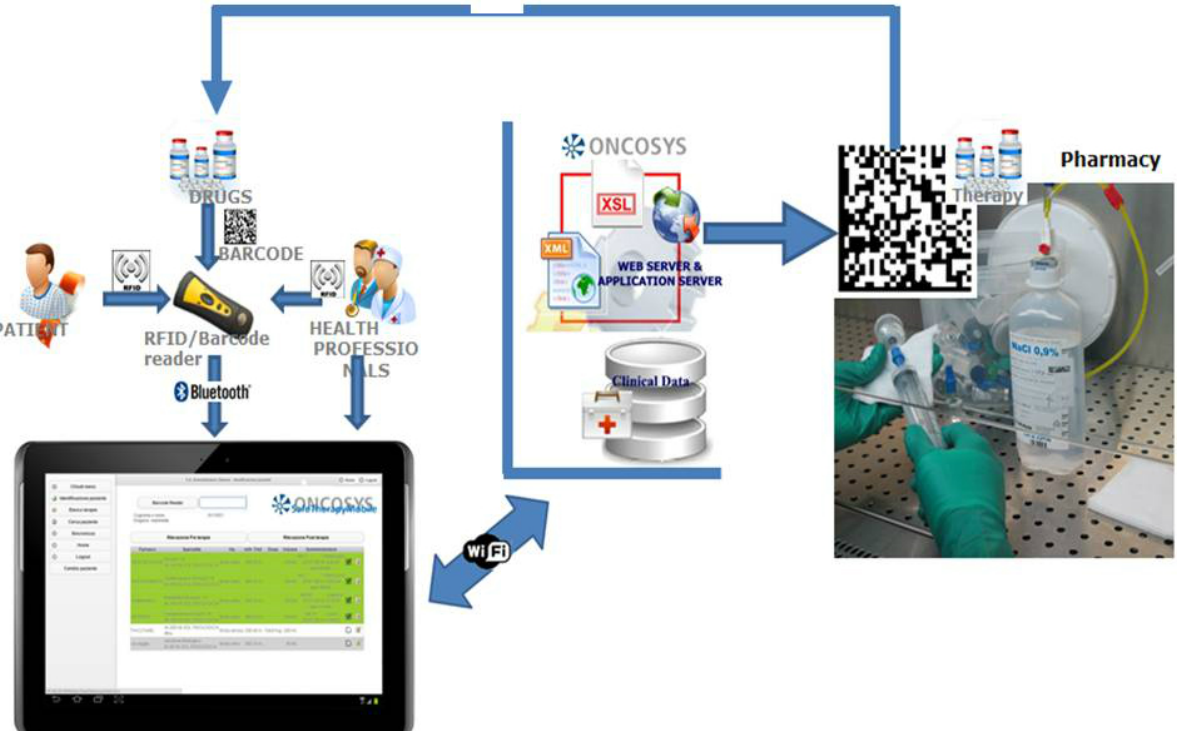
Figure 1. The basic components of the STM system. The eOPR originates a CPOE that is univocally associated with the patient’s RFID bracelet and the barcodes of the individual chemotherapy and ancillary drug, and washing solution. The RFID/barcode communicates via Bluetooth with the tablet, which communicates via Wi-Fi with the server of the OPR. The RFID/barcode reader checks the patient’s RFID bracelet, the nurse’s RFID, and the barcode on the infusion bag before each drug